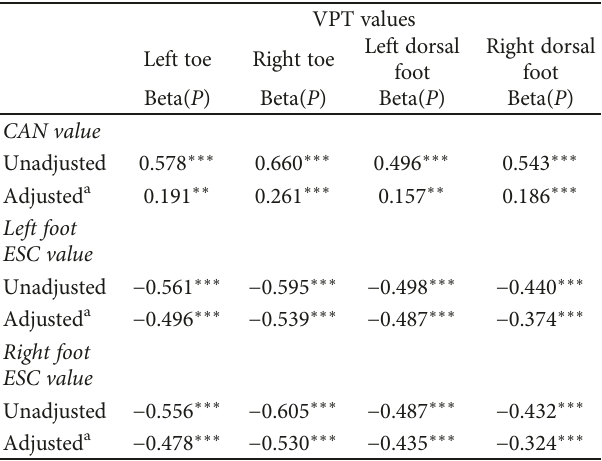
Table 3: Multivariate regression analyses of the association between the SUDOSCAN values and VPT indices.